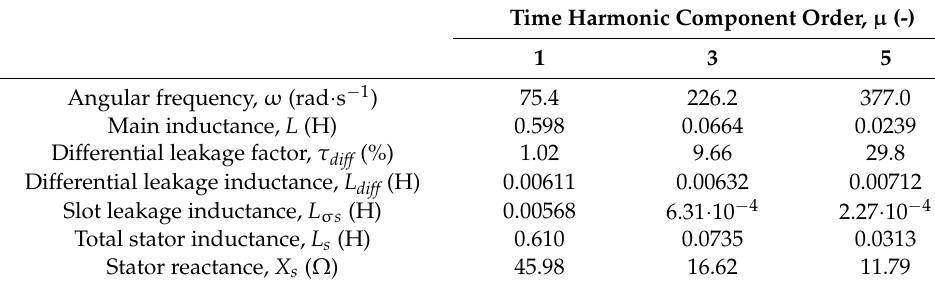
Table 4. Parameters of the machine under different time harmonic excitation.